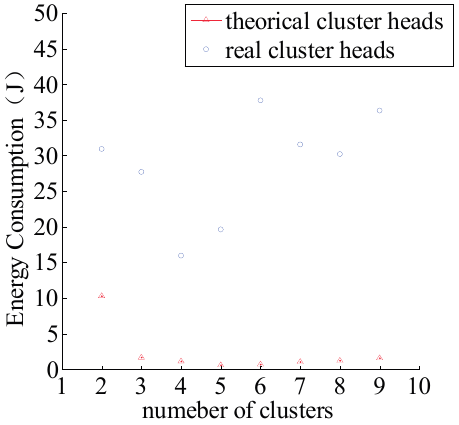
Figure 7. Different number of theoretical clusters and real clusters-energy consumption